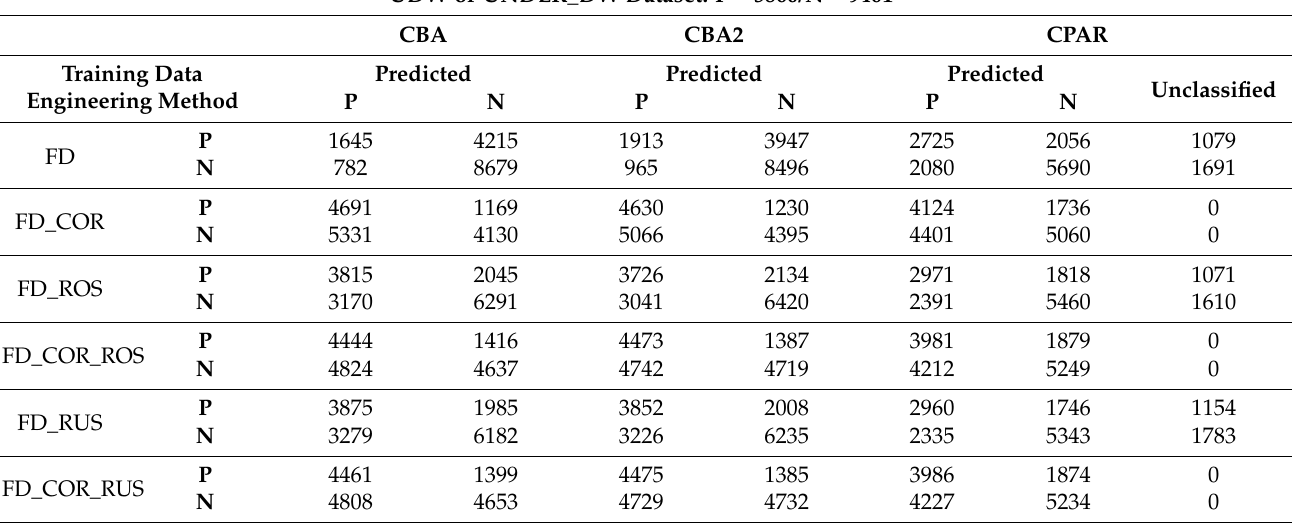
Table 8. UDW-or-UNDER_DW classification results (confusion matrixes) per algorithm and training data engineering